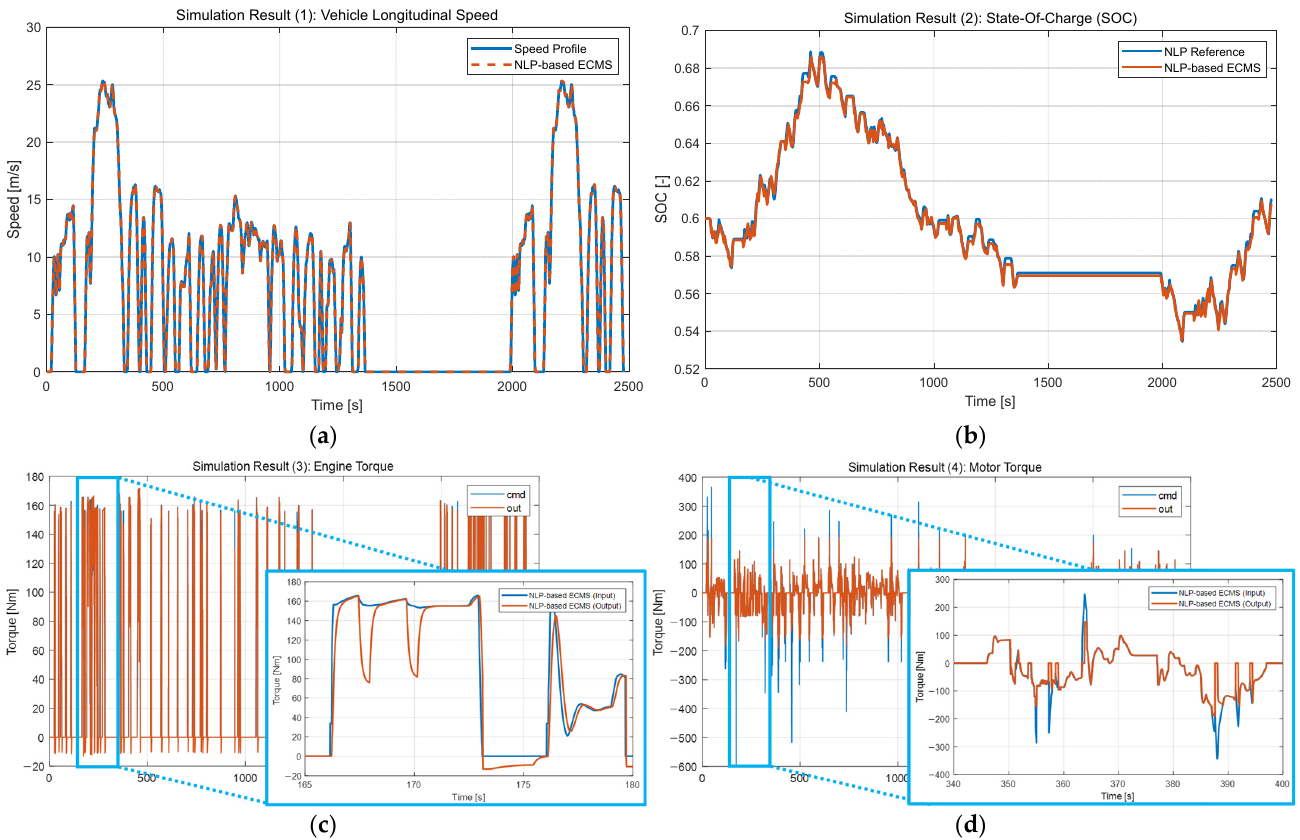
Figure 13. Autonomie (P2 HEV) simulation result with an EMS (NLP-based ECMS): ( a ) vehicle speed; ( b ) state of charge; ( c ) ICE torque; ( d ) EM torque.